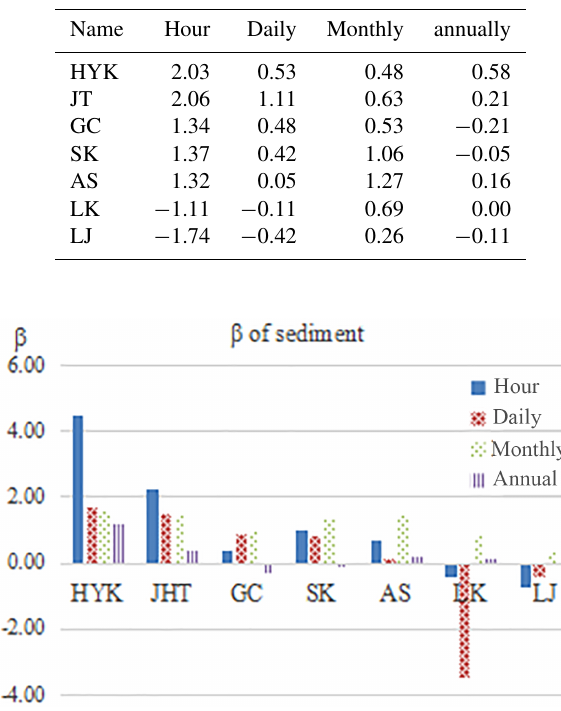
Table 2. Z c of sediment in different time scale.